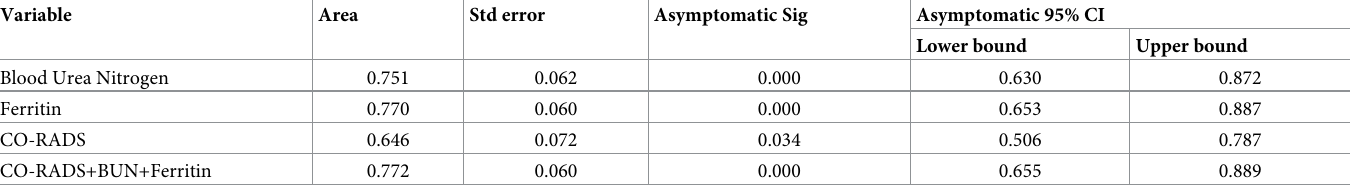
Table 5. COVID-19 Reporting and Data System (CO-RADS) based ROC plot output for highly significant biochemical properties.